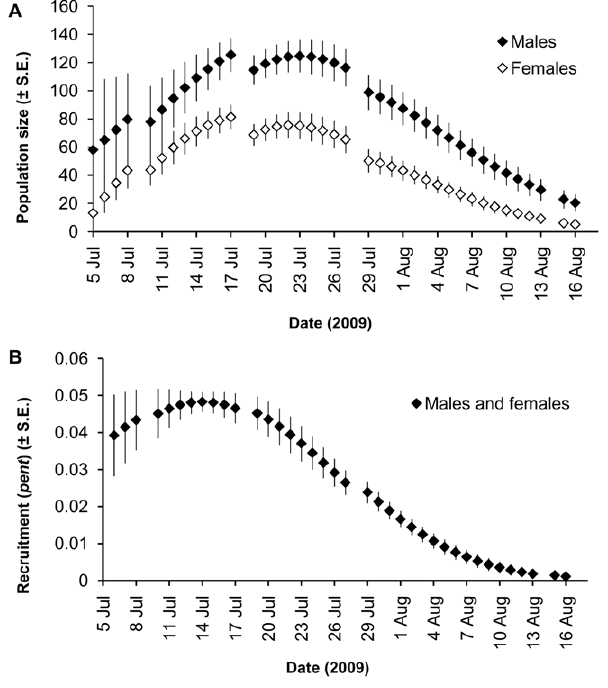
Figure 1. Daily estimates of population size (A) and recruit- ment (B) of the Rosalia longicorn in Slatinne Hills 2009. The estimates are derived from the mark-recapture data and modeled using the POPAN method in the program MARK. Used model: ( Q (g) p(t) Pent(T 2 ) N(g). doi:10.1371/journal.pone.0021345.g001 PLoS ONE |